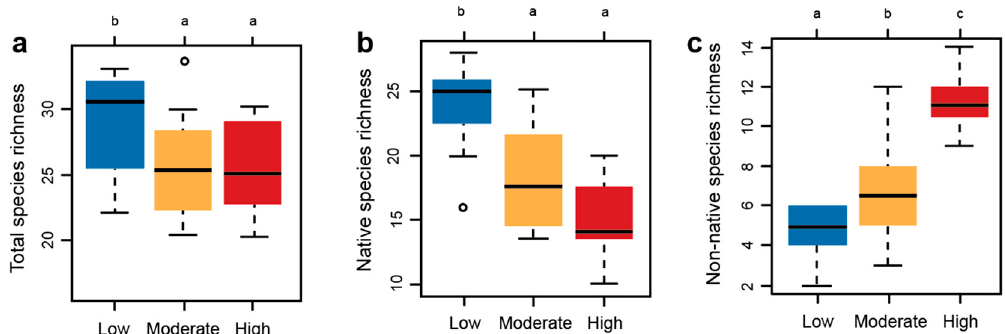
Figure 3. Total species richness ( a ), native species richness ( b ), and non-native species richness ( c ) in di ff erent levels of degradation. Data provided show the median (bold line), 25%–75% quartiles (boxes), ranges (whiskers), and outliers (white dot). Significant di ff erences are presented by di ff erent letters ( p < 0.05).